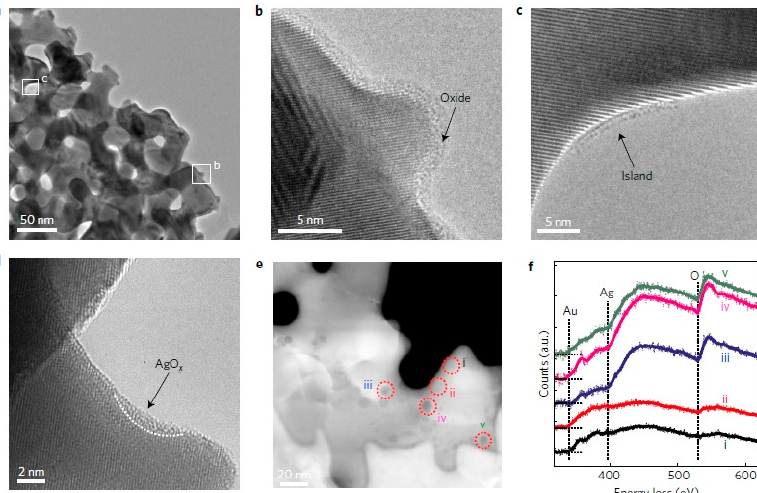
Figure 24. Nanoporous Au ad self-supported catalyst for selective alcohol oxidation: E-TEM analysis of nanoporous gold after ozone treatment showing ( a ) the porous and ligament structure of the sample; ( b ) the presence of an oxide layer due to ozone treatment; ( c ) the presence of crystalline islands; ( d ) TEM of amorphous oxide at the surface corresponding to silver-oxide species; ( e ) spots analysed by EELS; ( f ) EELS analysis showing the region of high Ag and O content. Reprinted by permission from [217]. Copyright 2016, Macmillan Publishers Ltd.